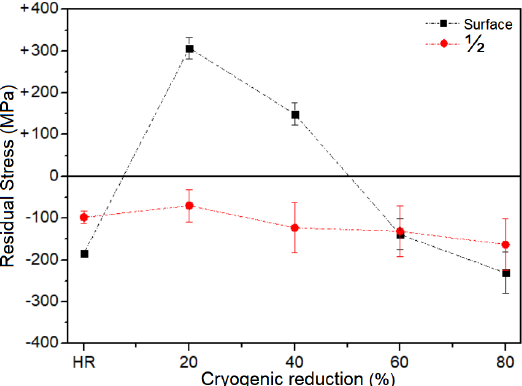
Figure 4. Residual stress profile of the α’-martensite phase in cryogenic rolling samples: HR-CR-20, HR-CR-40, HR-CR-60 and HR-CR-80.